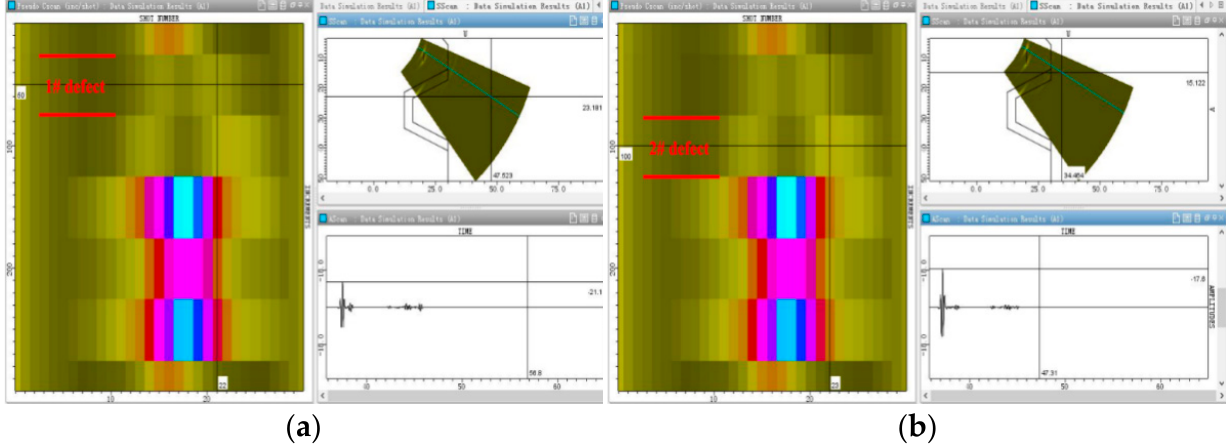
Figure 12. Simulation analysis of two kinds of crack defect signal echoes. ( a ) Defect 1#. ( b ) Defect 2#.